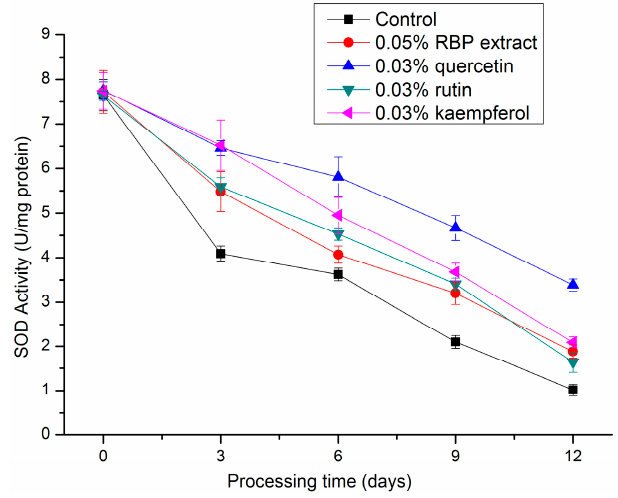
Figure 5. Changes in SOD activity during the processing of salami with different treatments.